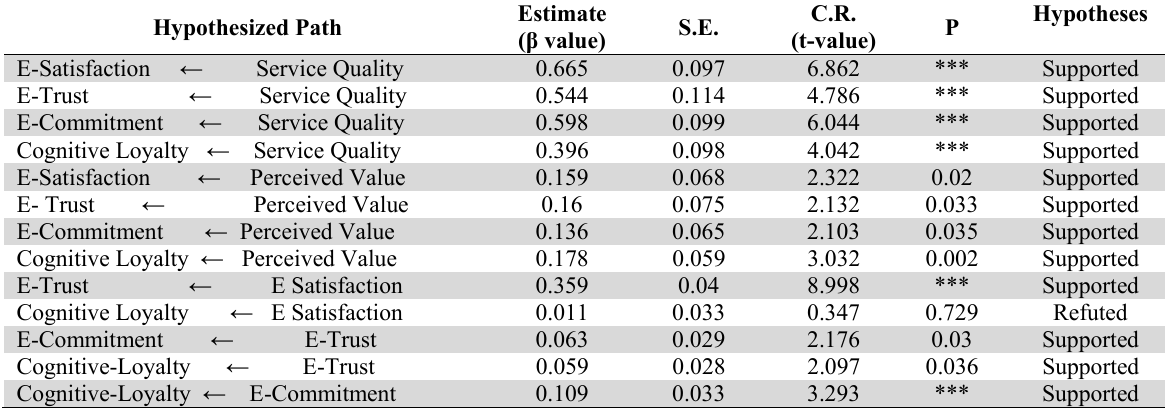
Results of Estimation Structural